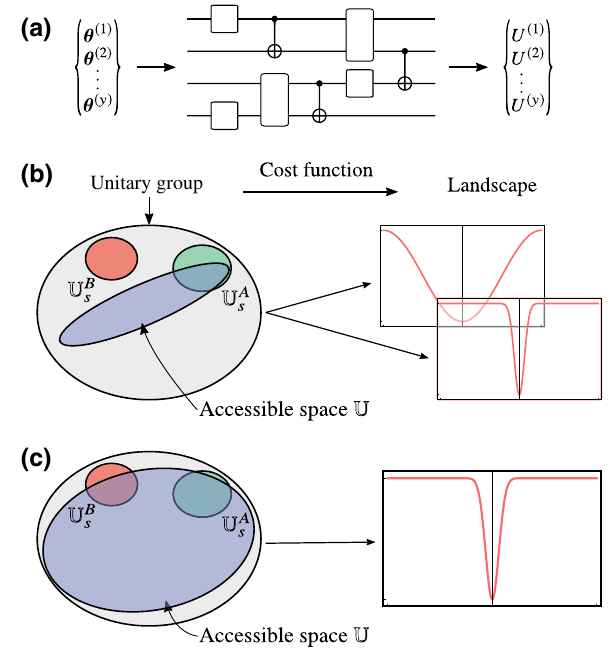
FIG. 1. A schematic representation of the main results. (a) Variational quantum algorithms (VQAs) train the parameters θ in a parametrized quantum circuit to minimize a cost function as in Eq. (1). Each set of parameters corresponds to a unitary U ( θ ) being produced. The set of unitaries U accessible by U ( θ ) is a subset of the unitary group U ( d ) and the VQA can be suc- cessful if U overlaps with the space of solution unitaries U s that (approximately) minimize the cost. The expressibility of an ansatz quantifies the degree to which it uniformly explores the unitary group U ( d ) . Given problems A and B , we denote and U B , respectively. (b) A low- their solution spaces as U A s s expressibility ansatz contains solutions to problem A but not to B , while a high-expressibility ansatz as in (c) contains solutions to both problems. Low-expressibility ansatze can lead to both small and large cost gradients. On the other hand, high-expressibility ansatze lead to predominantly flat cost landscapes and thus are generally hard to